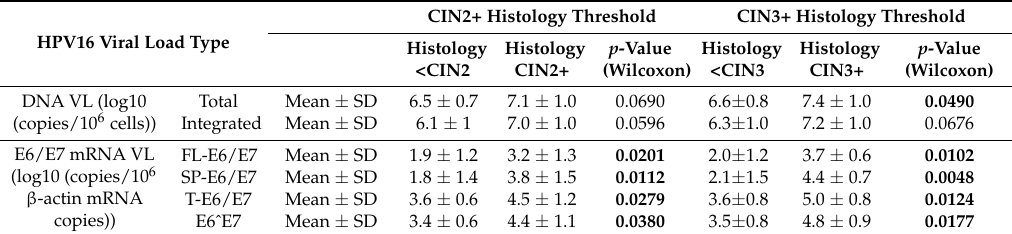
Table 5. Statistical analysis of HPV16 DNA and E6/E7 mRNA VLs variations in high grade cervical